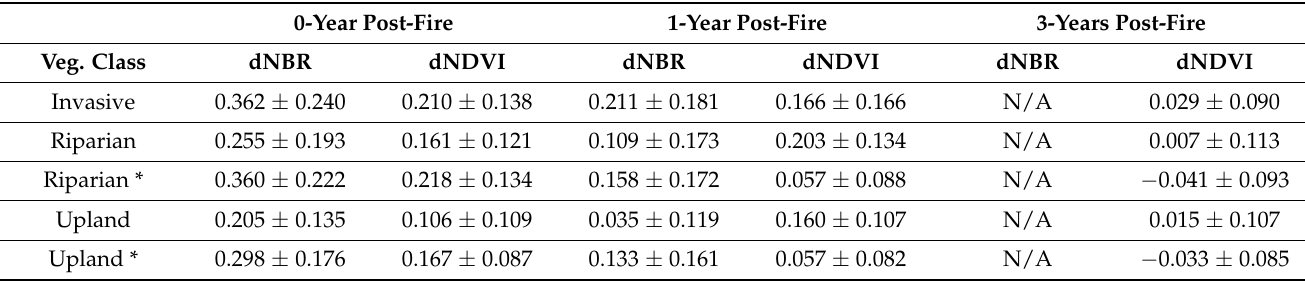
Table 3. Mean dNBR and dNDVI values and standard deviations by vegetation class for each point in time. Control fire vegetation classes are denoted by *. 0-Year Post-Fire 1-Year Post-Fire 3-Years